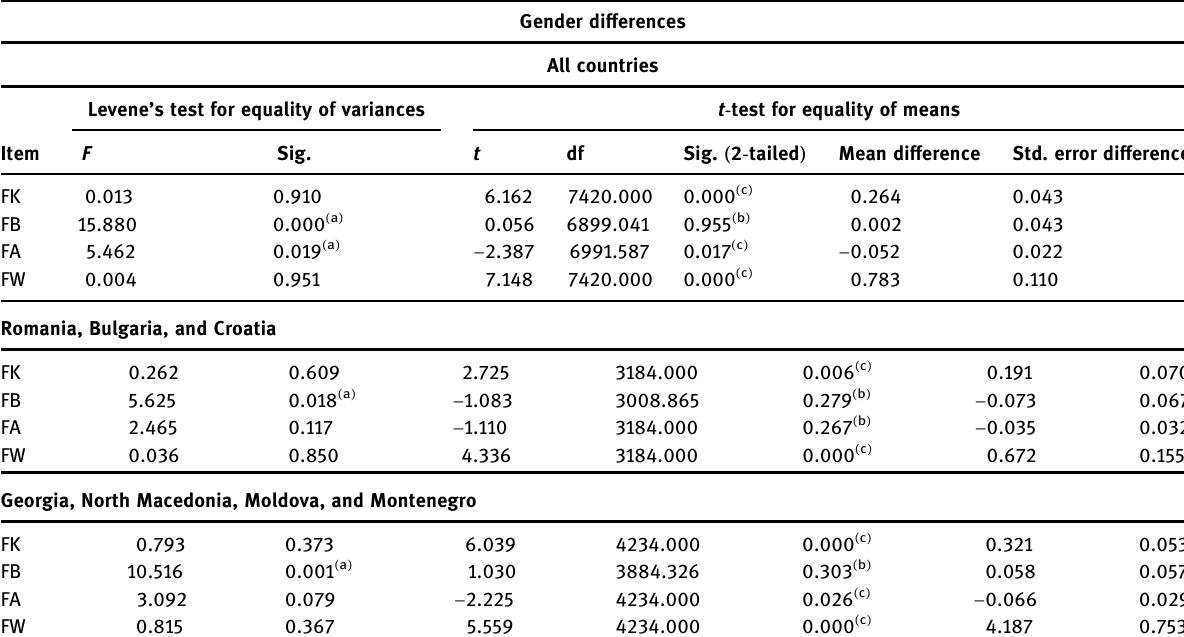
Table 6: Results of gender analysis means comparison